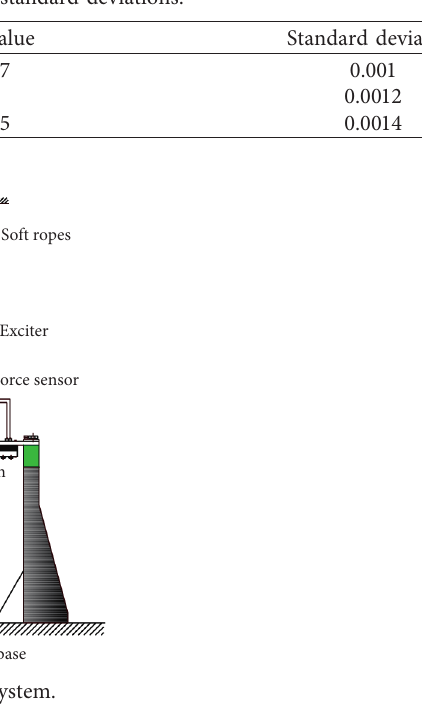
Figure 7: Sketch of the hysteresis loop for EMWM. (a) Energy consumption in one test cycle; (b) maximum deformation energy stored in one test cycle. Table 2: Loss factor of EMWM specimens with their standard